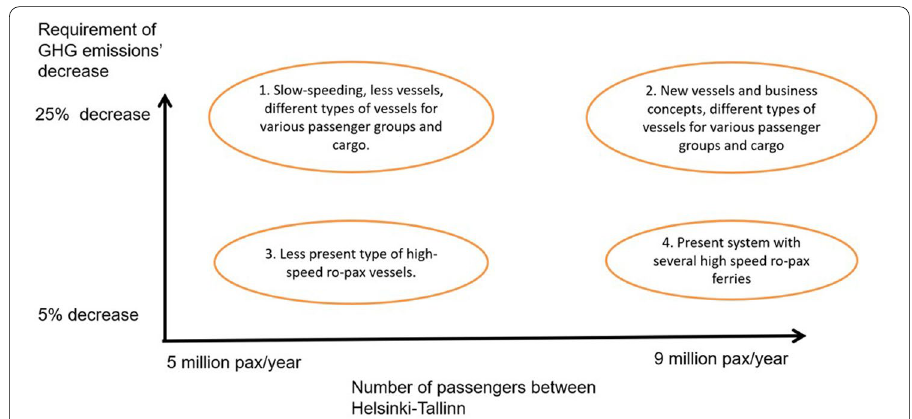
Fig. 7 Four scenarios for Helsinki-Tallinn traffic for the year 2030. Source : Authors’ own